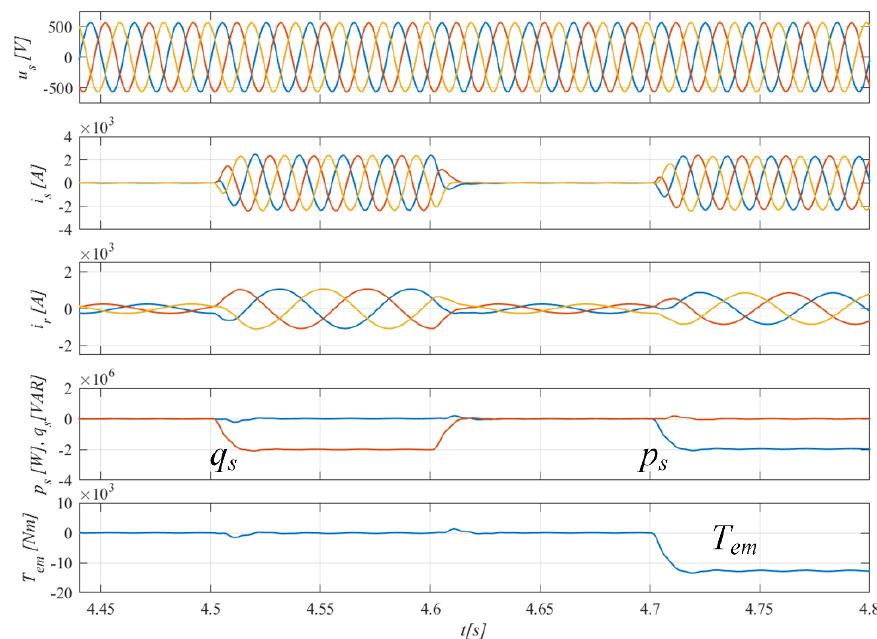
Figure 7. Direct power control simulation results of DFIG in case of symmetrical grid voltage with no feedforward and decoupling mechanism implemented.